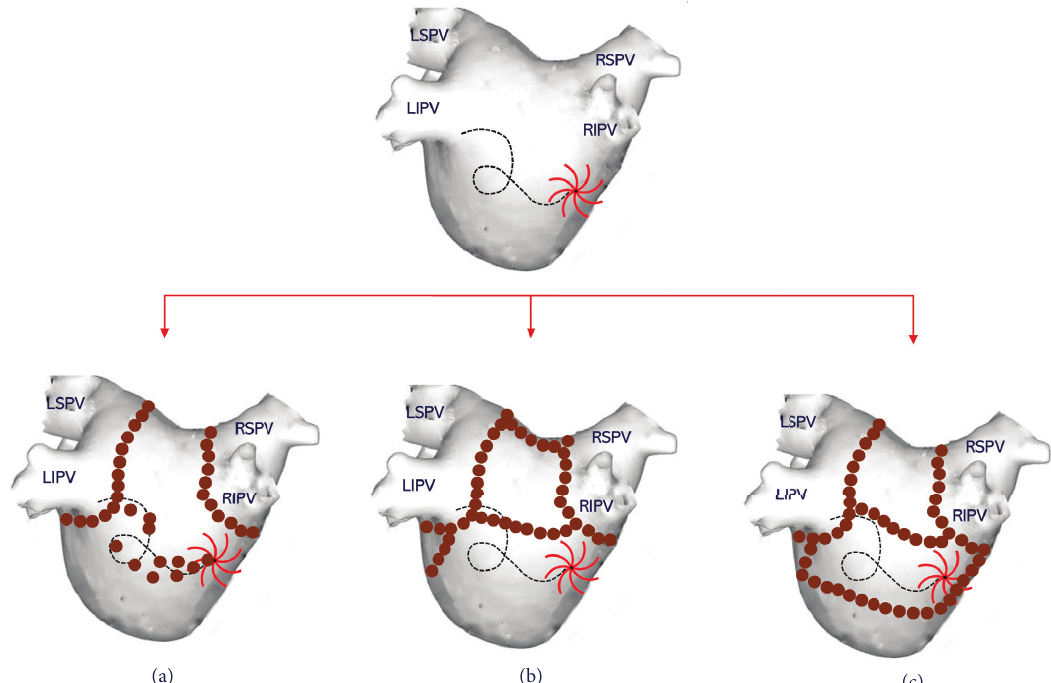
Figure 13: Possible ablation techniques, beyond PVI, after revealing an AF driver. (a) Direct targeting of the rotor path. (b) Standard linear lesions (box lesion and mitral isthmus block). (c) Linear isolation of the rotor